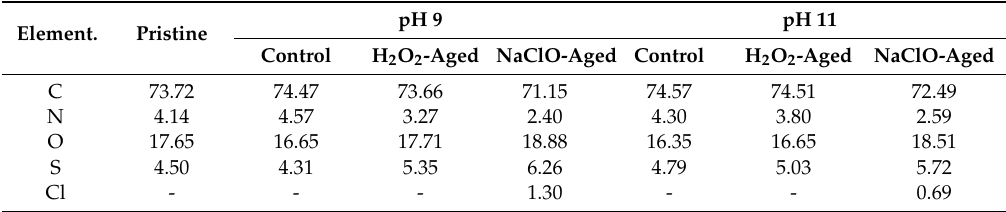
Figure 4. ATR-FTIR spectra of pristine and aged PES membrane: ( a ) 1800–1000 cm − 1 , ( b ) partial enlarged view of 1790–1760 cm − 1 , and ( c ) partial enlarged view of 1040–1020 cm − 1 . (I) pristine; (II) control (pH 9); (III) H 2 O 2 -aged (pH 9); (IV) NaClO-aged (pH 9); (V) control (pH 11); (VI) H 2 O 2 -aged (pH 11); and (VII) NaClO-aged (pH 11). Control membrane indicates membrane samples aged in NaOH solution with pH 9 or 11, c(H 2 O 2 ) = c(NaClO) = 5000 mg / L, t = 100 h. Table 1. Atomic percentage of elements (at%) of pristine and aged PES membranes. Control membrane indicates membrane samples aged in NaOH solution with pH 9 or 11, c(H 2 O 2 ) = c(NaClO) = 5000 mg / L, t = 100